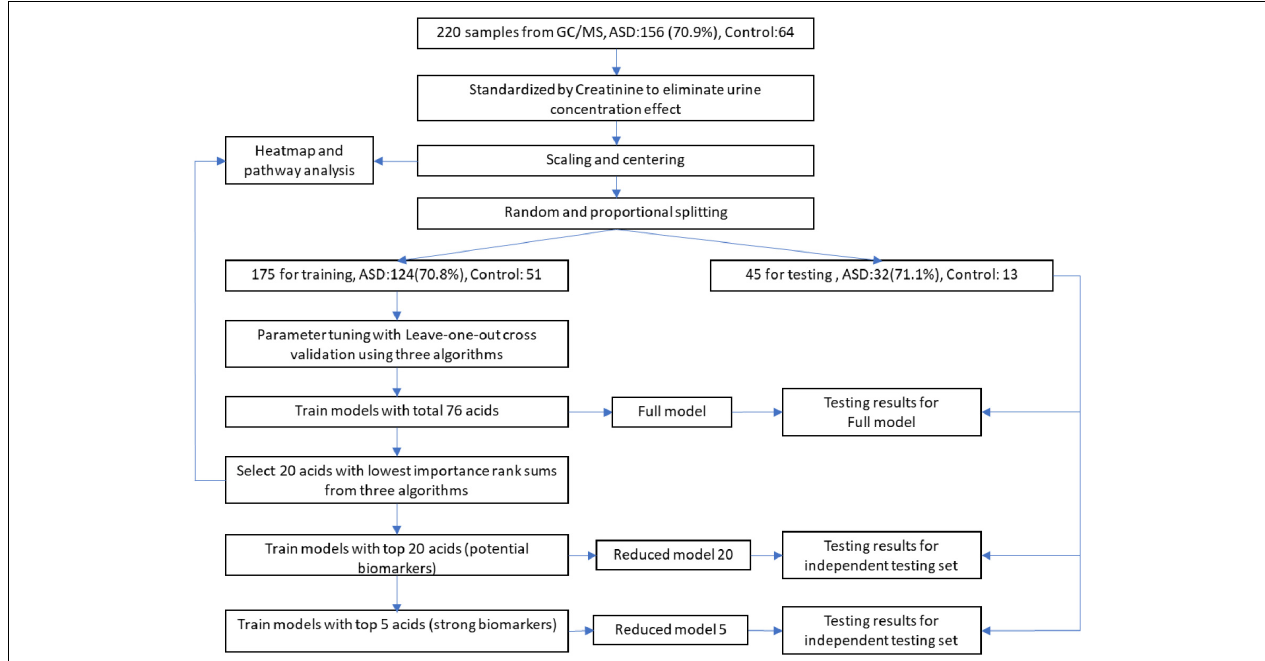
FIGURE 1 | Workflow of data processing and modeling. After standardization, scaling, and centering, sample data were split into training and testing sets, while testing set would be strictly excluded from any model building processes to minimize overfitting. Potential biomarkers were discovered by selecting top N acids from an importance rank sum list generated by three different classification algorithms, while N was determined from testing results of different N -values. The discovered biomarkers’ potential mechanisms were investigated through heatmap along with associated metabolic pathways.